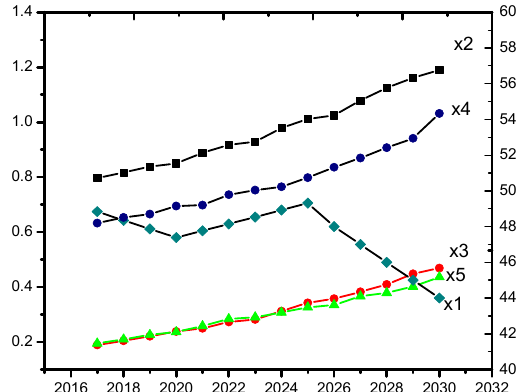
Figure 4. Predictions for the energy availability of ESSI.